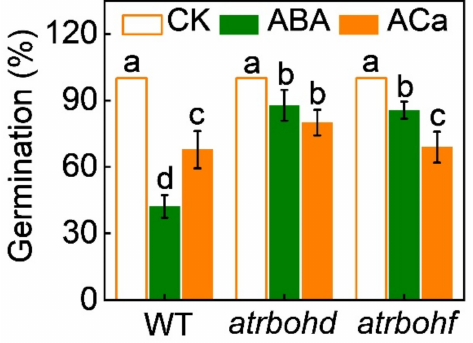
Figure 6. The effects of ABA and combination of ABA and CaCl 2 (ACa) on the germination rates of seeds in wild-type (WT) Arabidopsis and atrbohd and atrbohf mutants. Germination rates were recorded on the seventh day after seed incubation. Data are means ± SD (3 replicates × 30 seeds). The different letters denote a significant difference ( p < 0.05) according to Tukey’s